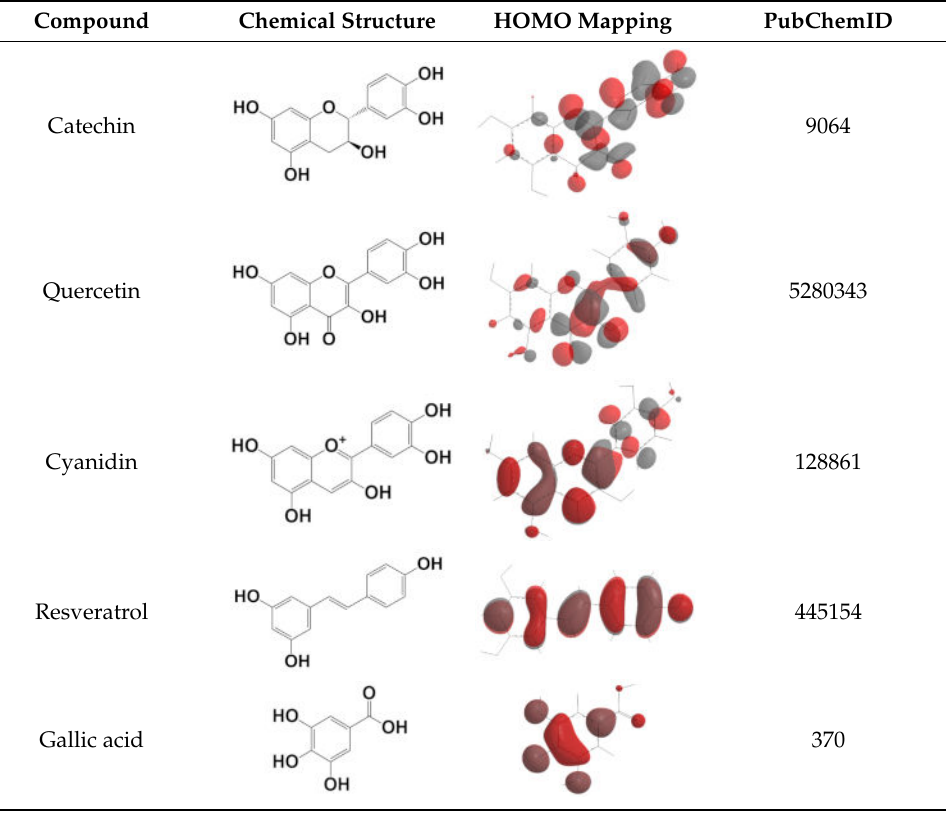
Table 1. Selected ubiquitous antioxidant markers in wine, as well as their structures, HOMO map- pings and PubChemID. The electro-accumulation regions in the HOMO mapping are showcased in dark gray and red color, accounting for positive and negative charges, respectively. All atoms and bonds are colored in black to aid